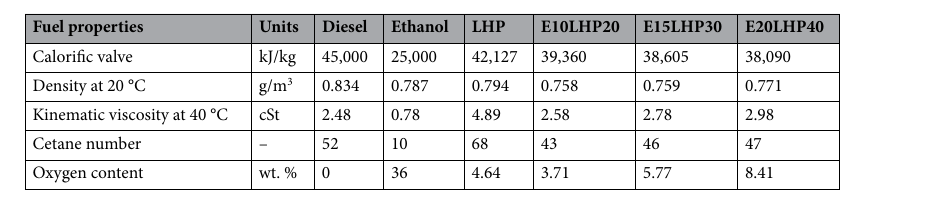
Table 3. Comparison of Physico-chemical properties of ternary